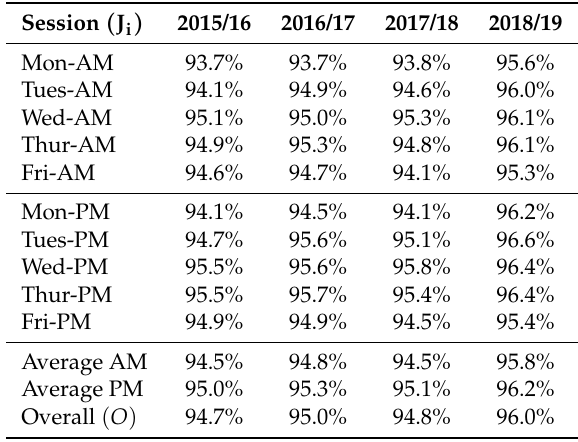
Table 7. Average attendance for 2015/16, 2016/17, 2017/18, and